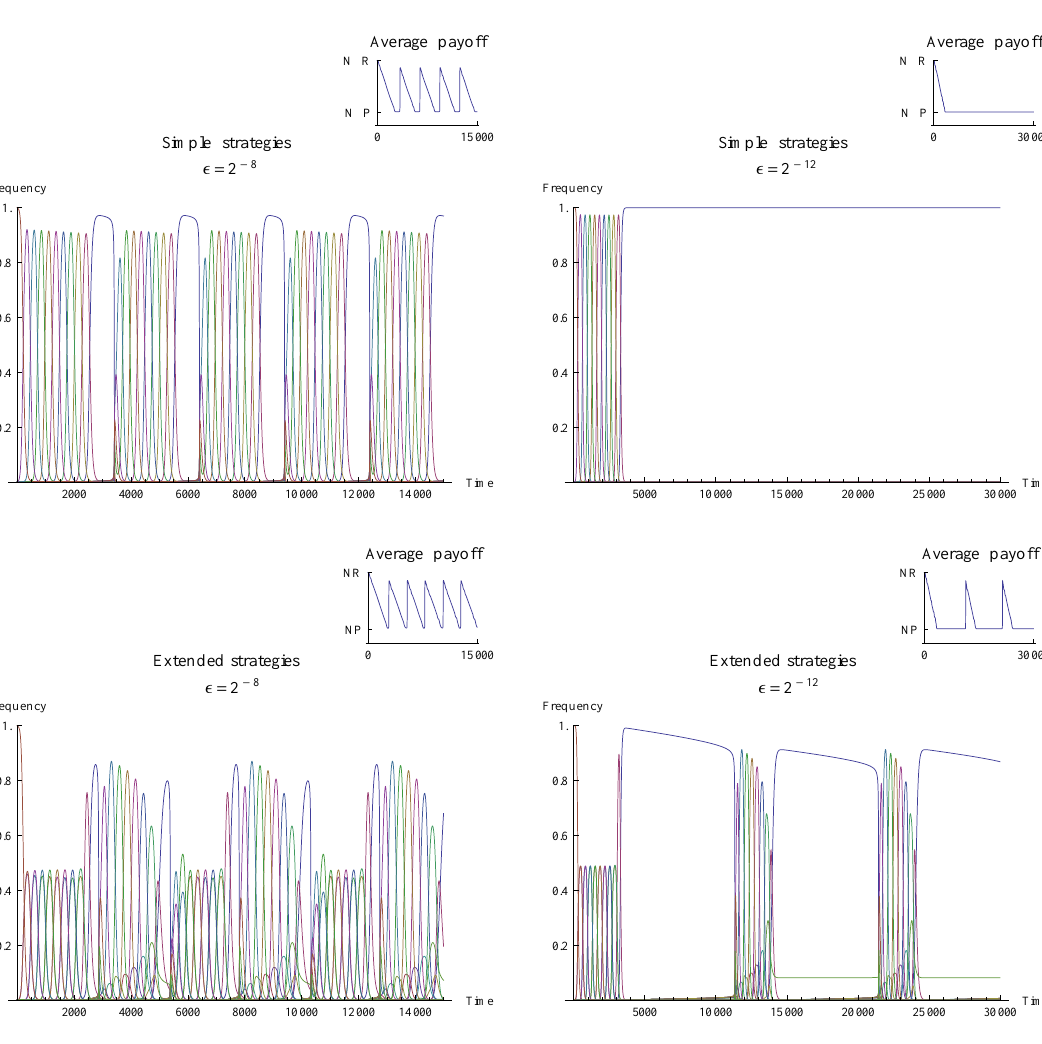
Figure 3. Illustration of the dynamics for a particular game (P=0.2, T=1.33) for 10-round Repeated Prisoners’ Dilemma ( N = 10